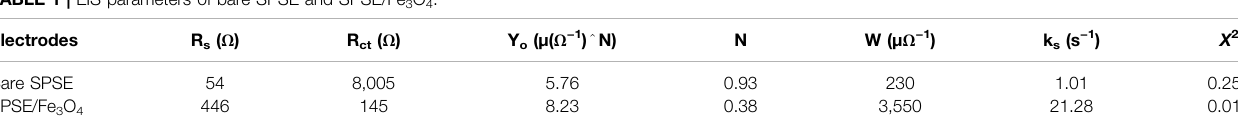
TABLE 1 | EIS parameters of bare SPSE and SPSE/Fe 3 O 4 .